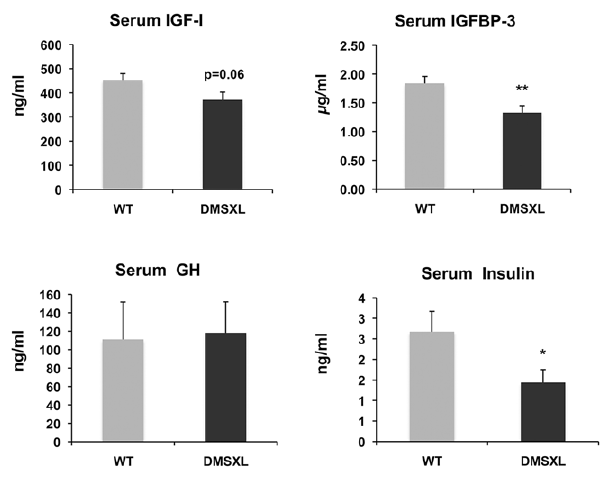
Figure 8. Circulating levels of growth-related signaling pro- teins after fasting. Significant decreases of IGFBP-3 and insulin levels were observed in 4-month-old homozygous DMSXL. A decrease of IGF-I was also observed but did not reach statistical significance. GH levels were variable but similar between DMSXL and WT. Data are presented as means 6 SEM (* p , 0.05, ** p , 0.01, Student’s t test or Mann- Whitney test), n=12 biological replicates per group.